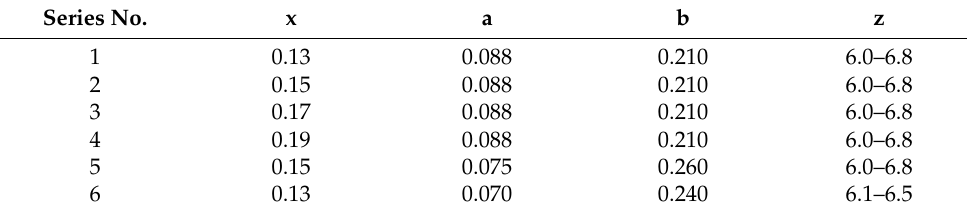
Table 1. Chemical composition of Sm 1 − x Zr x (Co 1 − a − b Cu a Fe b ) z experimental series alloys. Series